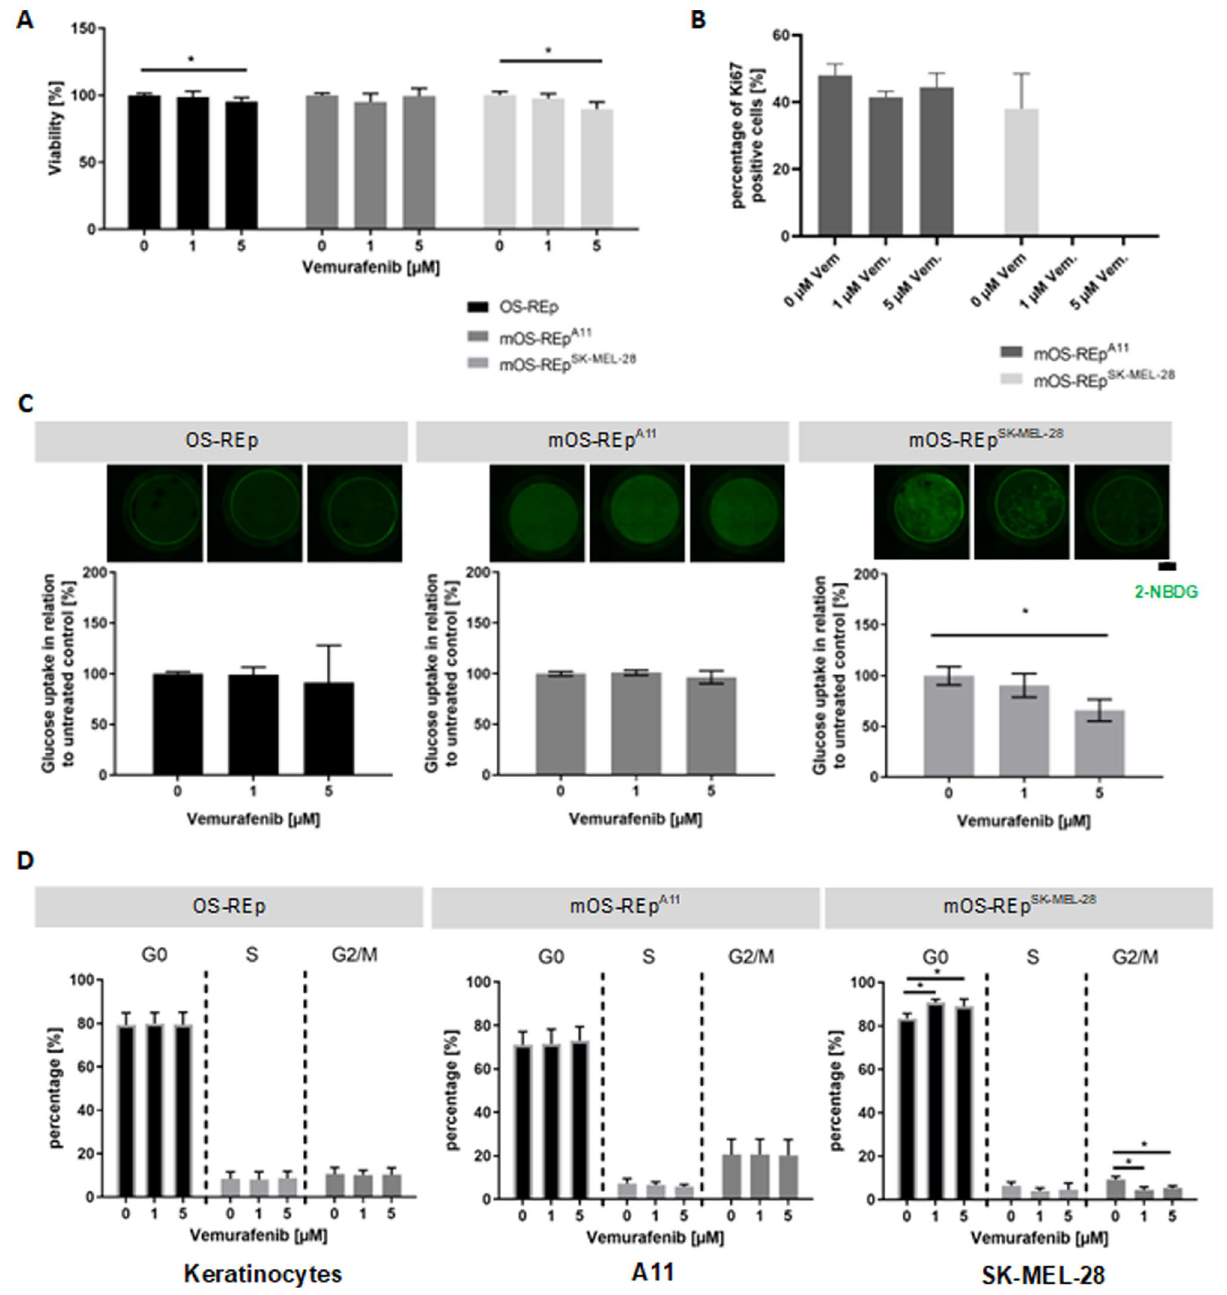
Figure 5. Qualification of mOS-REp as a test system for the assessment of tumor therapeutics. ( A ) Analysis of metabolic activity. mOS-REp A11 showed no significant difference in viability for different concentrations. In comparison, for OS-REp and mOS-REp SK-MEL-28 weak but statistically relevant decreases of viability were measurable for 5 µM vemurafenib. ( B ) Influence on proliferation rates. Melanoma cells re-isolated from BRAF WT (mOS-REp A11 ) and BRAF V600E (mOS-REp SK-MEL-28 ) melanoma skin equivalents were stained on cytospots (Fig. S2) with the proliferation marker Ki67 and counted quantitatively. In mOS-REp SK-MEL-28 the number of positively stained cells diminished completely after treatment, whereas the Ki67 expression was not altered by vemurafenib treatment in mOS-REp A11 . ( C ) Measurement of glucose consumption. It was either directly measured in the supernatant or visualized locally by fluorescently labelled glucose. Both the fluorescent signal and glucose consumption decreased dose-dependently for mOS-REp SK-MEL-28 . This could not be observed in mOS-REp A11 . Scale bar 200 µm. ( D ) Treatment effects on the cell cycle. Cell cycle stages were determined by DNA content measured via flow cytometry after propidium iodide staining. Vemurafenib led to a dose- dependent significant increase of cells in G0 phase and decrease in G2/M phase in mOS-REp SK-MEL-28 . OS-REp and mOS-REp A11 showed no treatment-dependent cell cycle